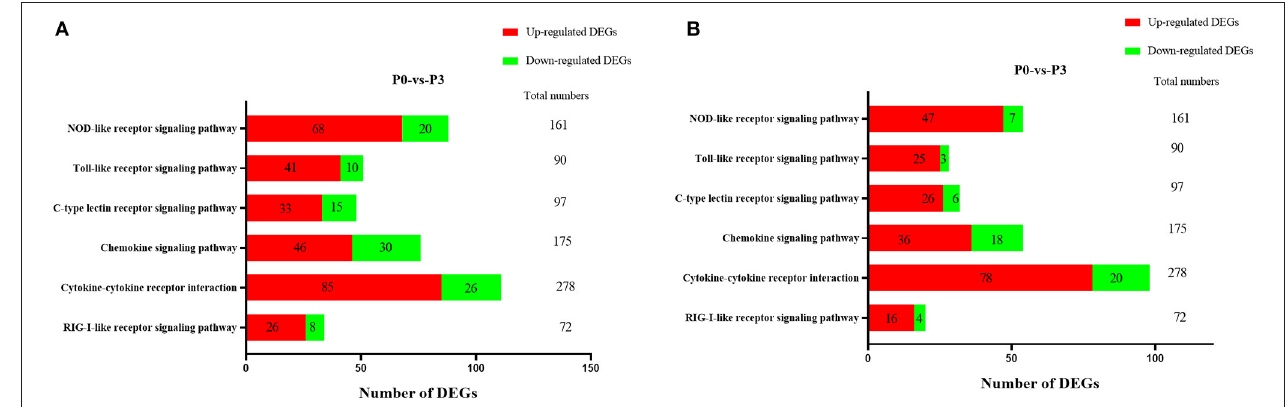
FIGURE 4 | The crucial immune system pathways enriched during P. multocida infection at 3 dpi. (A) DEGs with fold changes ≥ 1, (B) DEGs with fold changes ≥